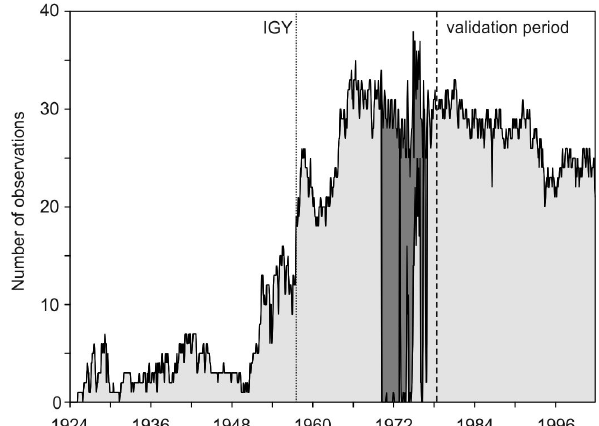
Fig. 2. Number of monthly mean values assimilated in the as- Figure 2. Number of monthly mean values assimilated in the assimilation period (1925-1978) and validation similation period (1925–1978) and validation period (1979–1999).